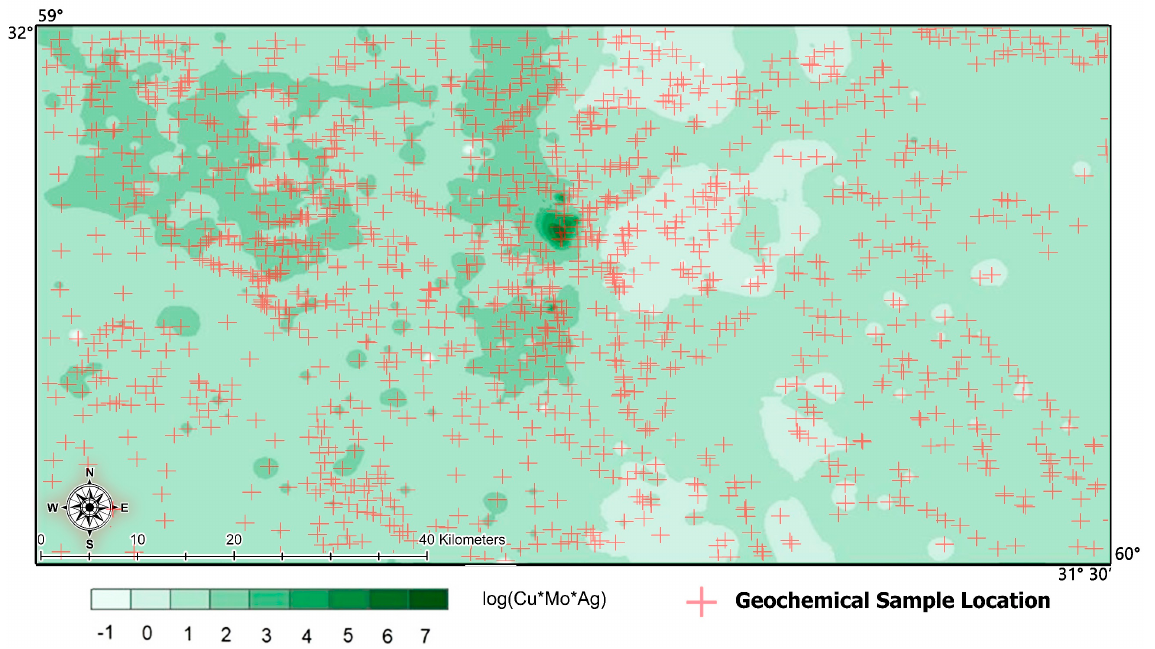
Figure 14. The map of sub-mineral elements distribution based on stream sediment samples (using IDW interpolation method).